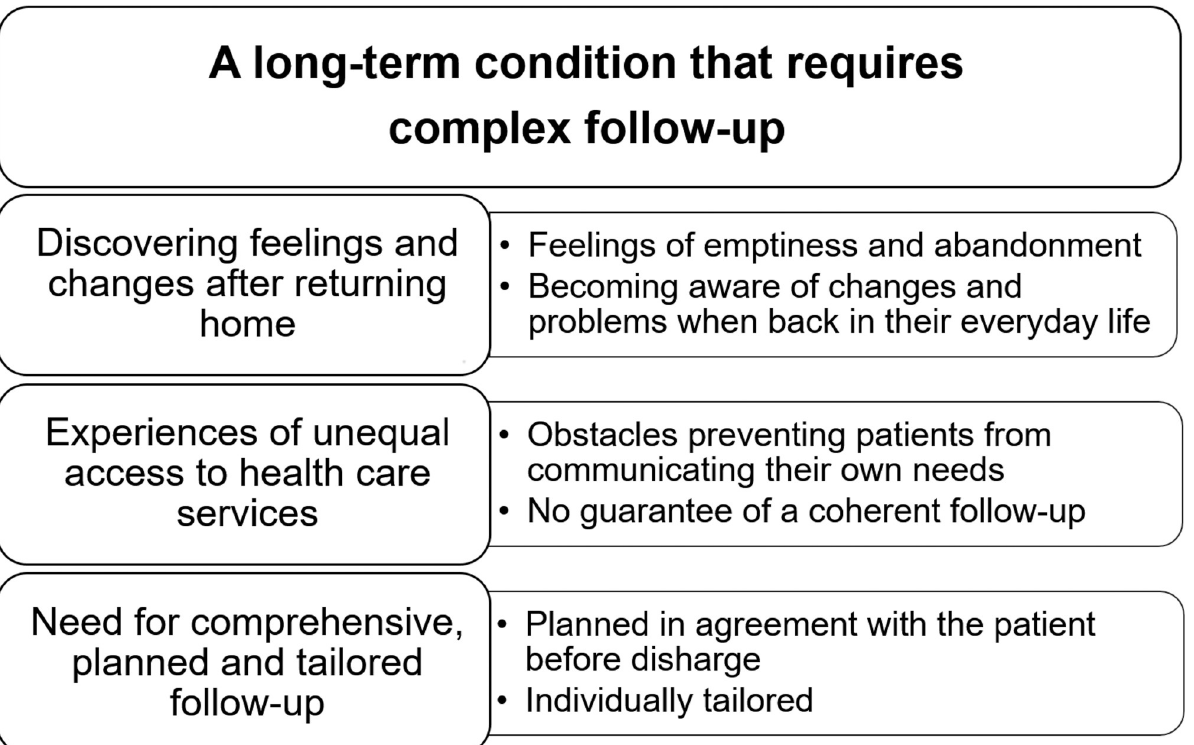
Fig 1. Themes and subthemes derived from the focus group discussions with people with stroke and healthcare professionals regarding the need for follow-up.